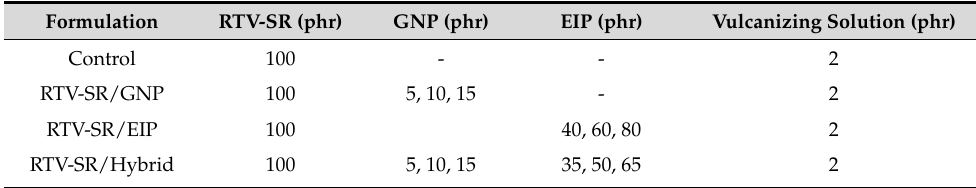
Table 1. Fabrication of the different rubber composites.